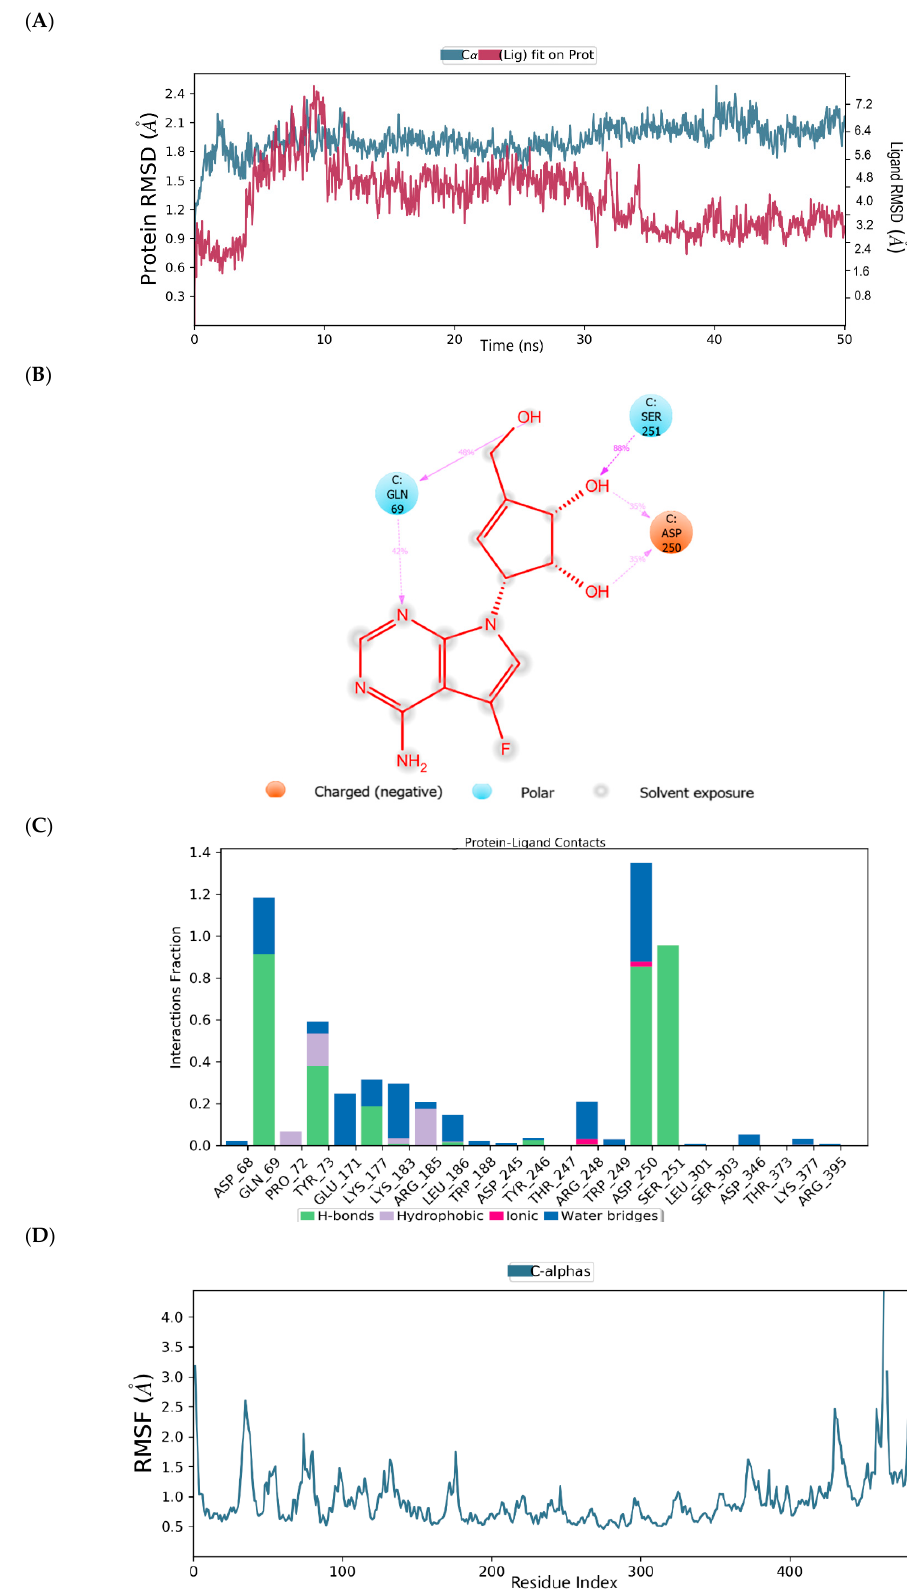
Figure 8. ( A ) MDSs trajectory output revealing the root-mean-square deviation (RMSD) plot of CID-16723073 bound to MNV RdRp; ( B ) Binding interaction of CID-16723073 -MNV RdRp after MDSs; ( C ) Ligplot representing interaction of CID-16723073 with different residues of MNV RdRp throughout the simulation trajectory ( D ) Graphical depiction of root-mean-square fluctuation (RMSF) of CID-16723073 with different residues of MNV